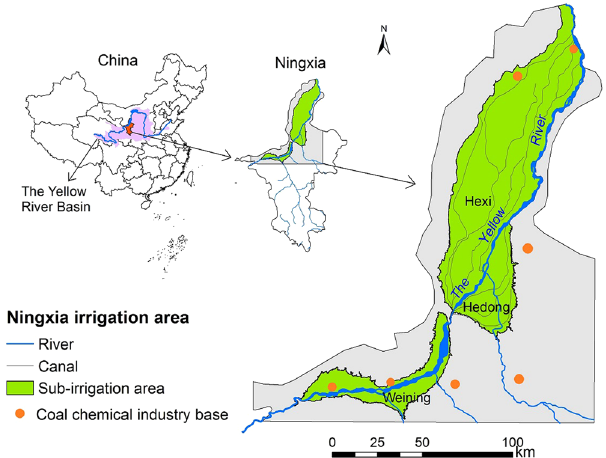
Figure 3. Study site. This figure was generated though ArcGIS 10.2 software provided by Environmental Systems Research Institute